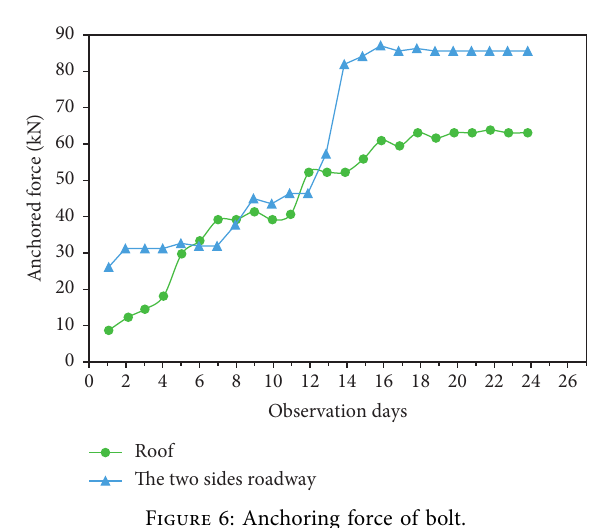
Figure 6: Anchoring force of